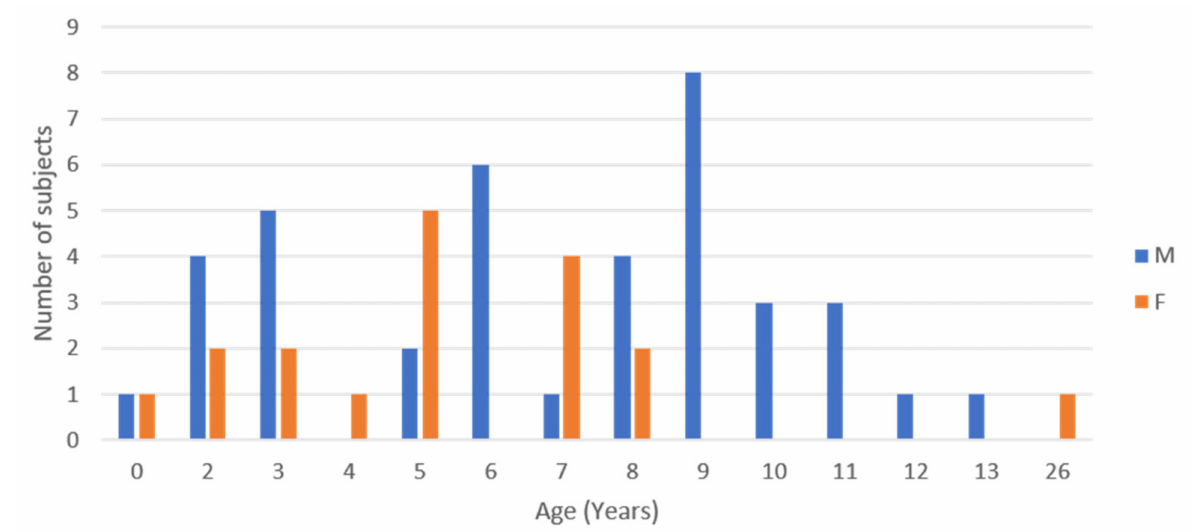
Figure 2. Number of children reached by the survey, divided by age. Blue bars refer to males, while orange to females. The survey revealed that 46 children had cerebral palsy (CP), 3 acquired brain injury, while 7 families did not respond. In addition, 16 of these children also suffered from epilepsy. Among the 46 children with CP, 38 had the spastic form, 4 the dyskinetic one, 2 the ataxic one, and 2 families did not answer (Figure 3a). Considering the type of CP, 20 had the left hemiplegia, 16 the right hemiplegia, 4 the diplegia, 4 the tetraplegia, and 2 families did not respond (Figure 3b).